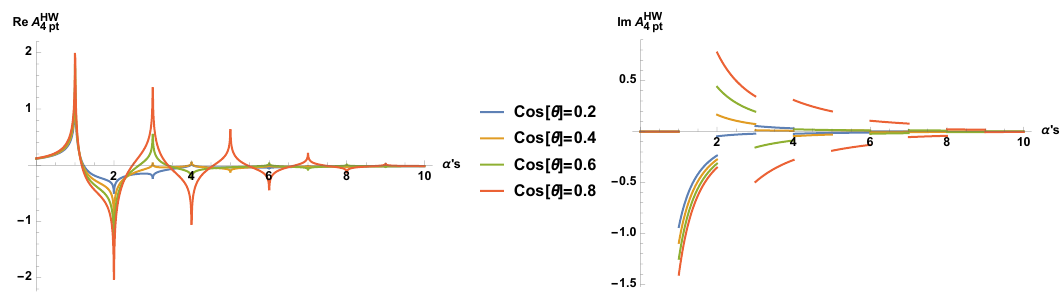
Figure 7 . Real and imaginary part of the open superstring amplitude in the hard wall background at different values of the